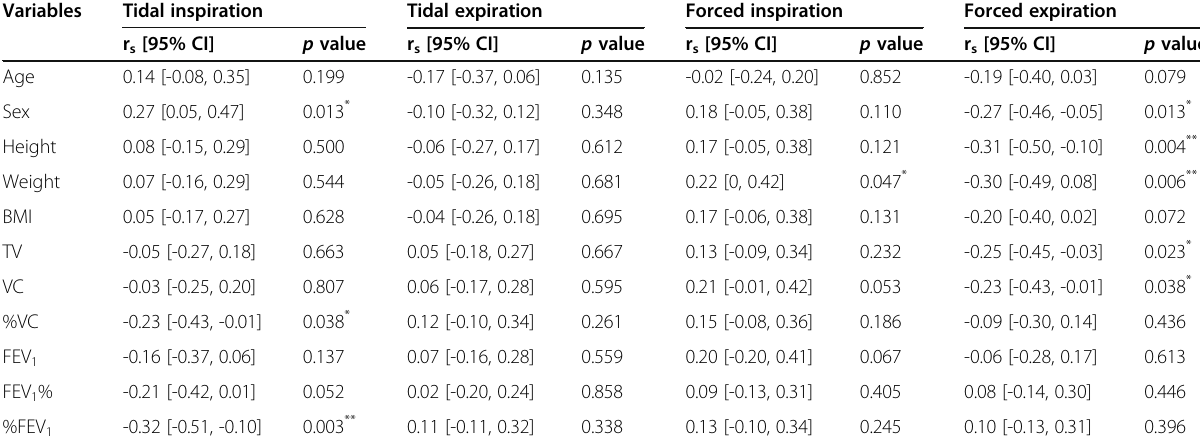
Table 3 Correlation between lung motion velocity in the left lung and demographic data